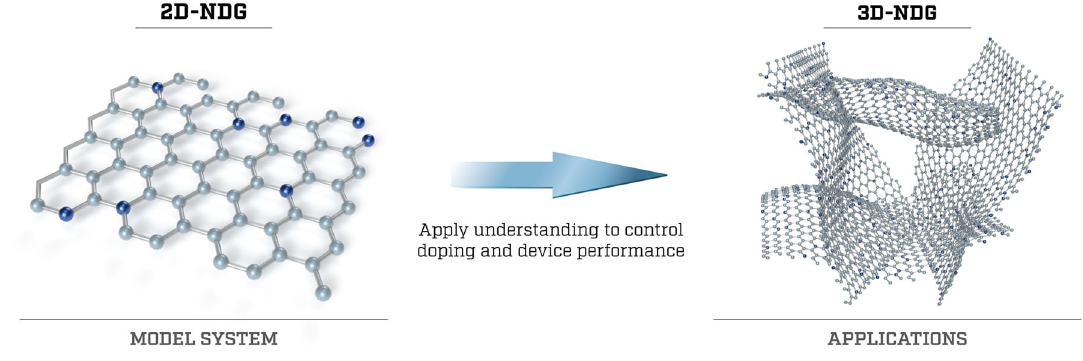
Fig. 12 Schematic illustration. Two-dimensional N-doped graphene (2D NDG) system that can be used as a model to control the N-doping at. %, location, and device performance effects ( fi eld-effect transistor). The results could be applied to control N-doping processes and device performance of 3D-NDG materials (e.g., electrochemistry